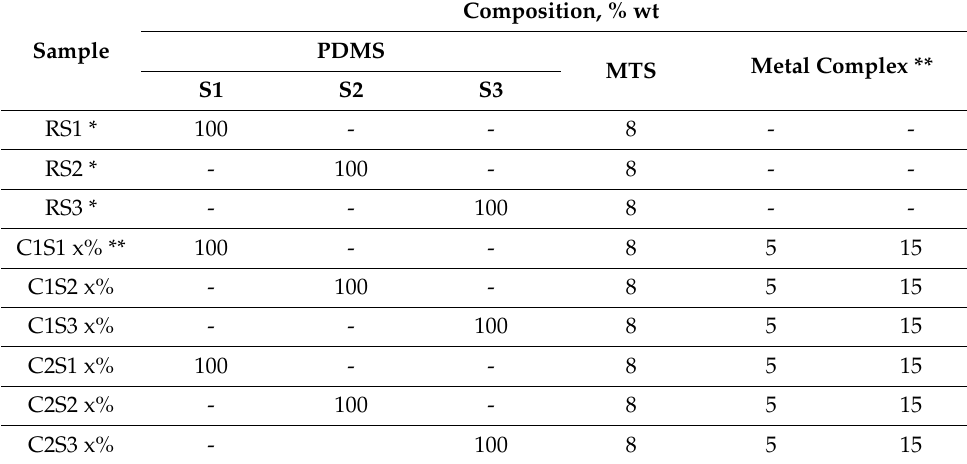
Table 1. The feed amounts of the precursors for film